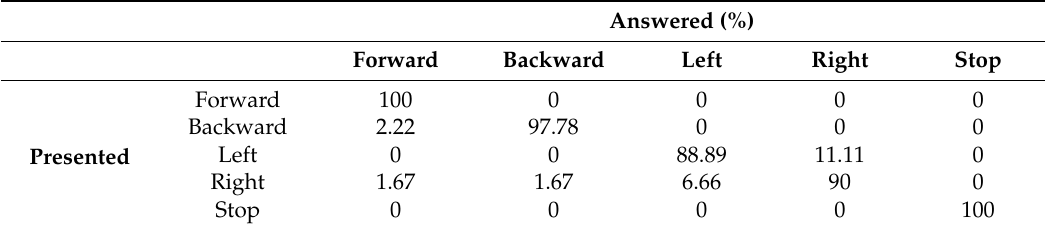
Table 1. Direction recognition rates with the user interface and the proposed tactile rendering approach.